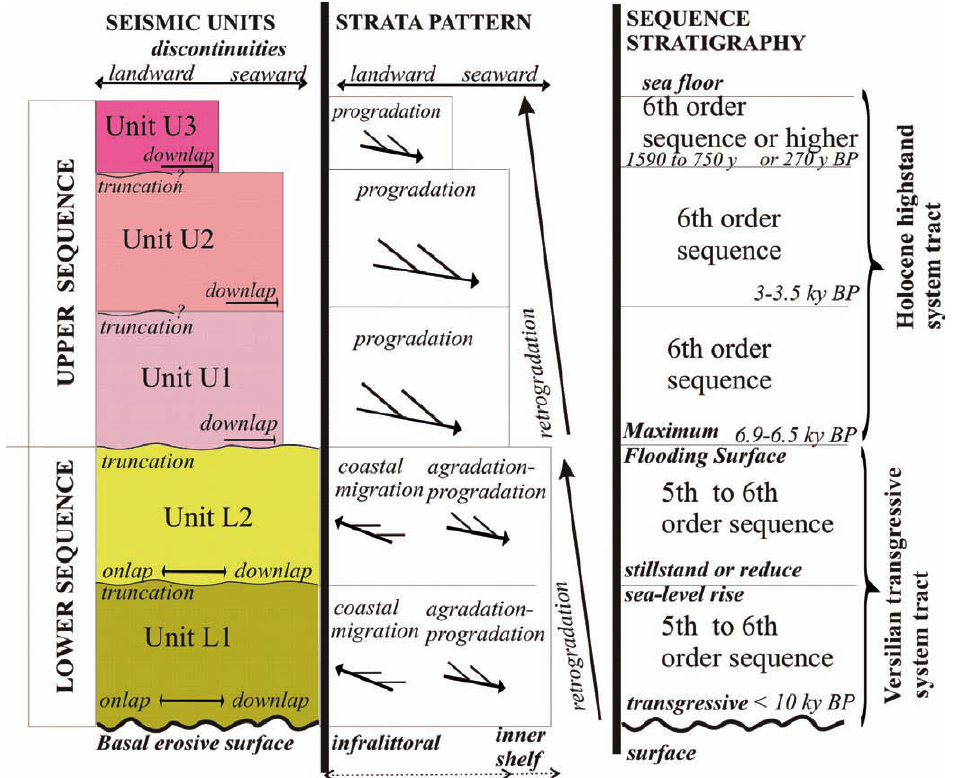
f ig . 7. – Schematic diagram showing type of boundaries, strata pattern and sequence stratigraphy age model of the stratigraphy defined in the El Masnou infralittoral